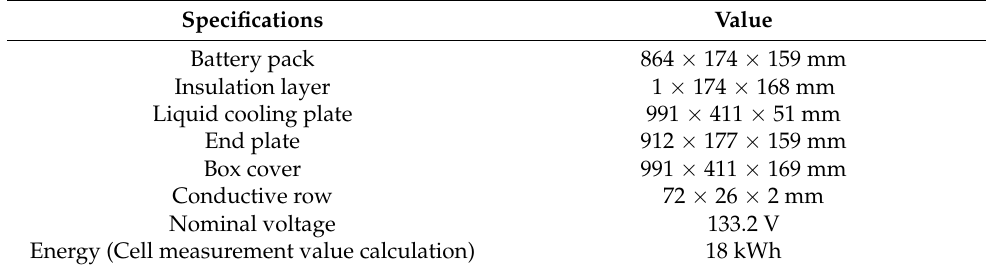
Table 1. Battery pack structure